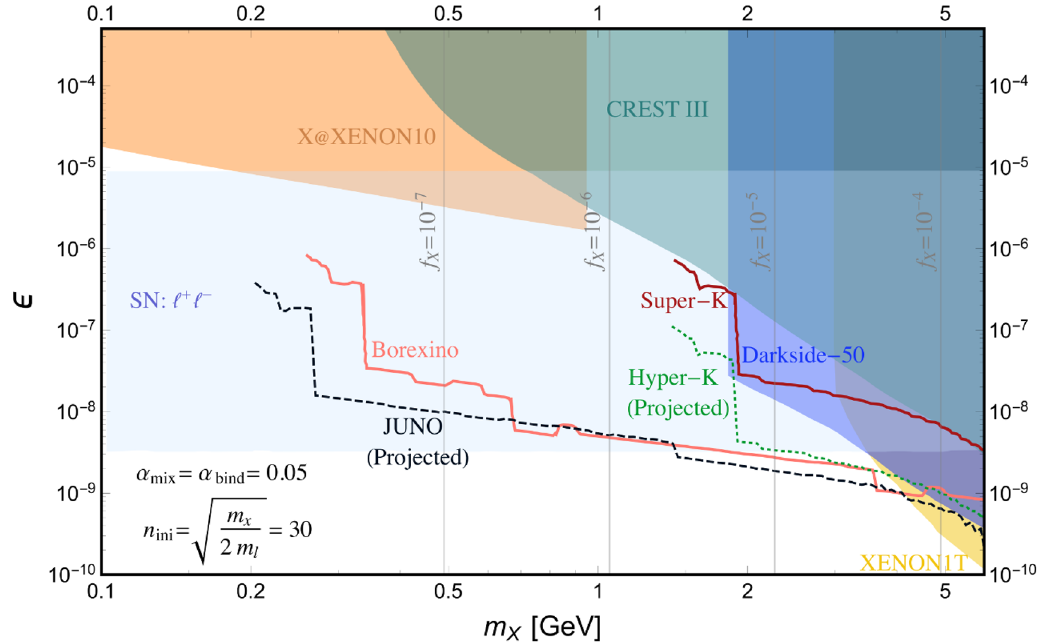
Figure 2. Bounds on the kinetic mixing in our scenario from Super-Kamiokande [20, 24] and Borexino [23] experiments together with projections for Hyper-Kamiokande [25] and Juno [26]. Also plotted are bounds from direct detection of the atomic states from XENON10 [34], CRESST [35], Darkside [36], XENON1T [37] and finally the bounds from SN1987a [27], which have been recently questioned [38]. The fraction f X is chosen to be the limiting one beyond which our atomic states are depleted (given in the horizontal